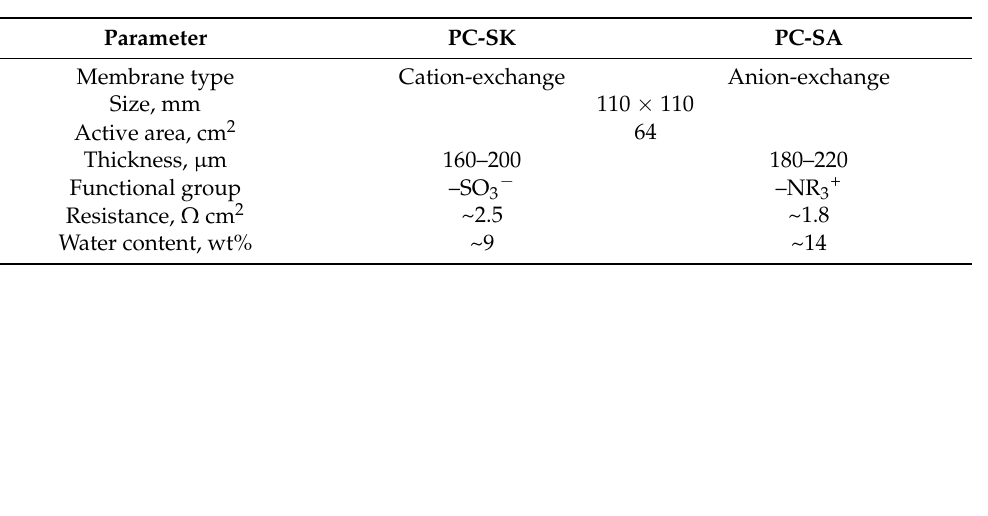
Table 1. Parameters of the experimental